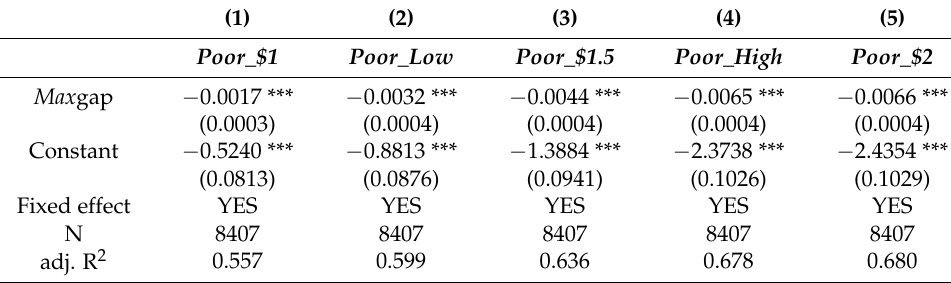
Table 6. Impact of daily temperature differences on poverty